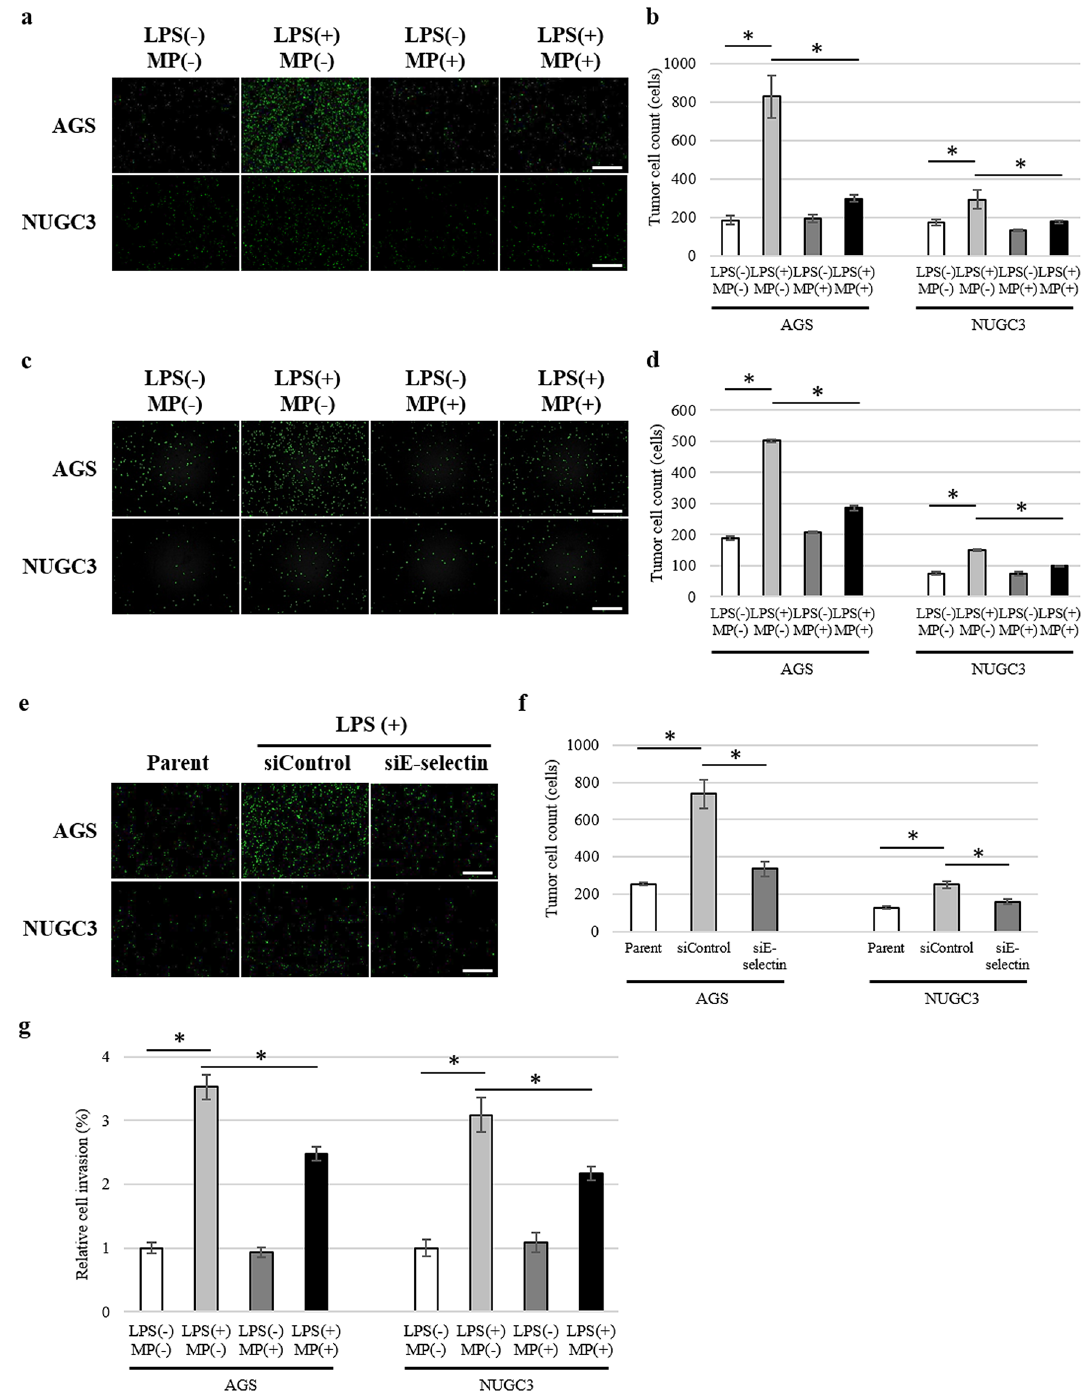
Figure 2. Adhesion of AGS and NUGC3 gastric cancer cells to vascular endothelial cells. ( a ) Representative images of the adhesion of tumour cells (AGS, upper; NUGC3, lower) to monolayer-cultured HUVEC stimulated by 1.0 µg/mL of LPS and 100 µg/mL of MP. Scale bars are equal to 500 µm. ( b ) Number of tumour-binding cells (AGS and NUGC3) to monolayer-cultured HUVEC stimulated by 1.0 µg/mL of LPS and 100 µg/mL of MP. Data are means ± standard error (n = 6, each group); * P < 0.05. ( c ) Representative images of the adhesion of tumour cells (AGS, upper; NUGC3, lower) to monolayer-cultured HHSEC stimulated by 1.0 µg/mL of LPS and 100 µg/ mL of MP. Scale bars are equal to 500 µm. ( d ) Number of tumour-binding cells (AGS and NUGC3) to monolayer-cultured HHSEC stimulated by 1.0 µg/mL of LPS and 100 µg/mL of MP. Data are means ± standard error (n = 6, each group); * P < 0.05. ( e ) Representative images of the adhesion of tumour cells (AGS, upper; NUGC3, lower) to monolayer-cultured HUVEC depleted of E-selectin stimulated by 1.0 µg/mL of LPS. Scale bars are equal to 500 µm. ( f ) Number of tumour-binding cells (AGS and NUGC3) to monolayer-cultured HUVEC depleted of E-selectin stimulated by 1.0 µg/mL of LPS. Data are means ± standard error (n = 6, each group); * P < 0.05. ( g ) Invasion assay of of AGS and NUGC3 gastric cancer cells co-cultured with HUVEC stimulated by 1.0 µg/mL of LPS and 100 µg/mL of MP. Data are means ± standard error (n = 5, each group); * P <